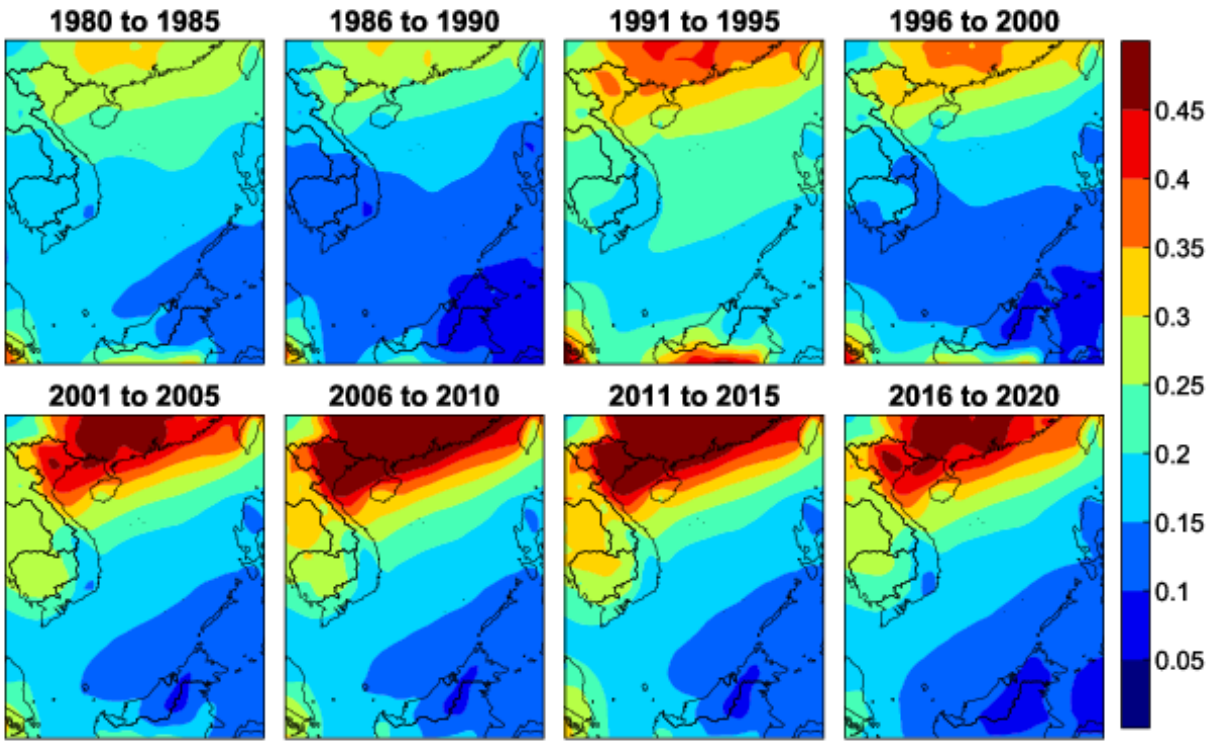
Figure 3. Variation of MERRA-2 AOD in 5-year intervals in the period of 1980–2020. Figure 4 illustrated the mean AOD in each month over the SCS between 1980 and